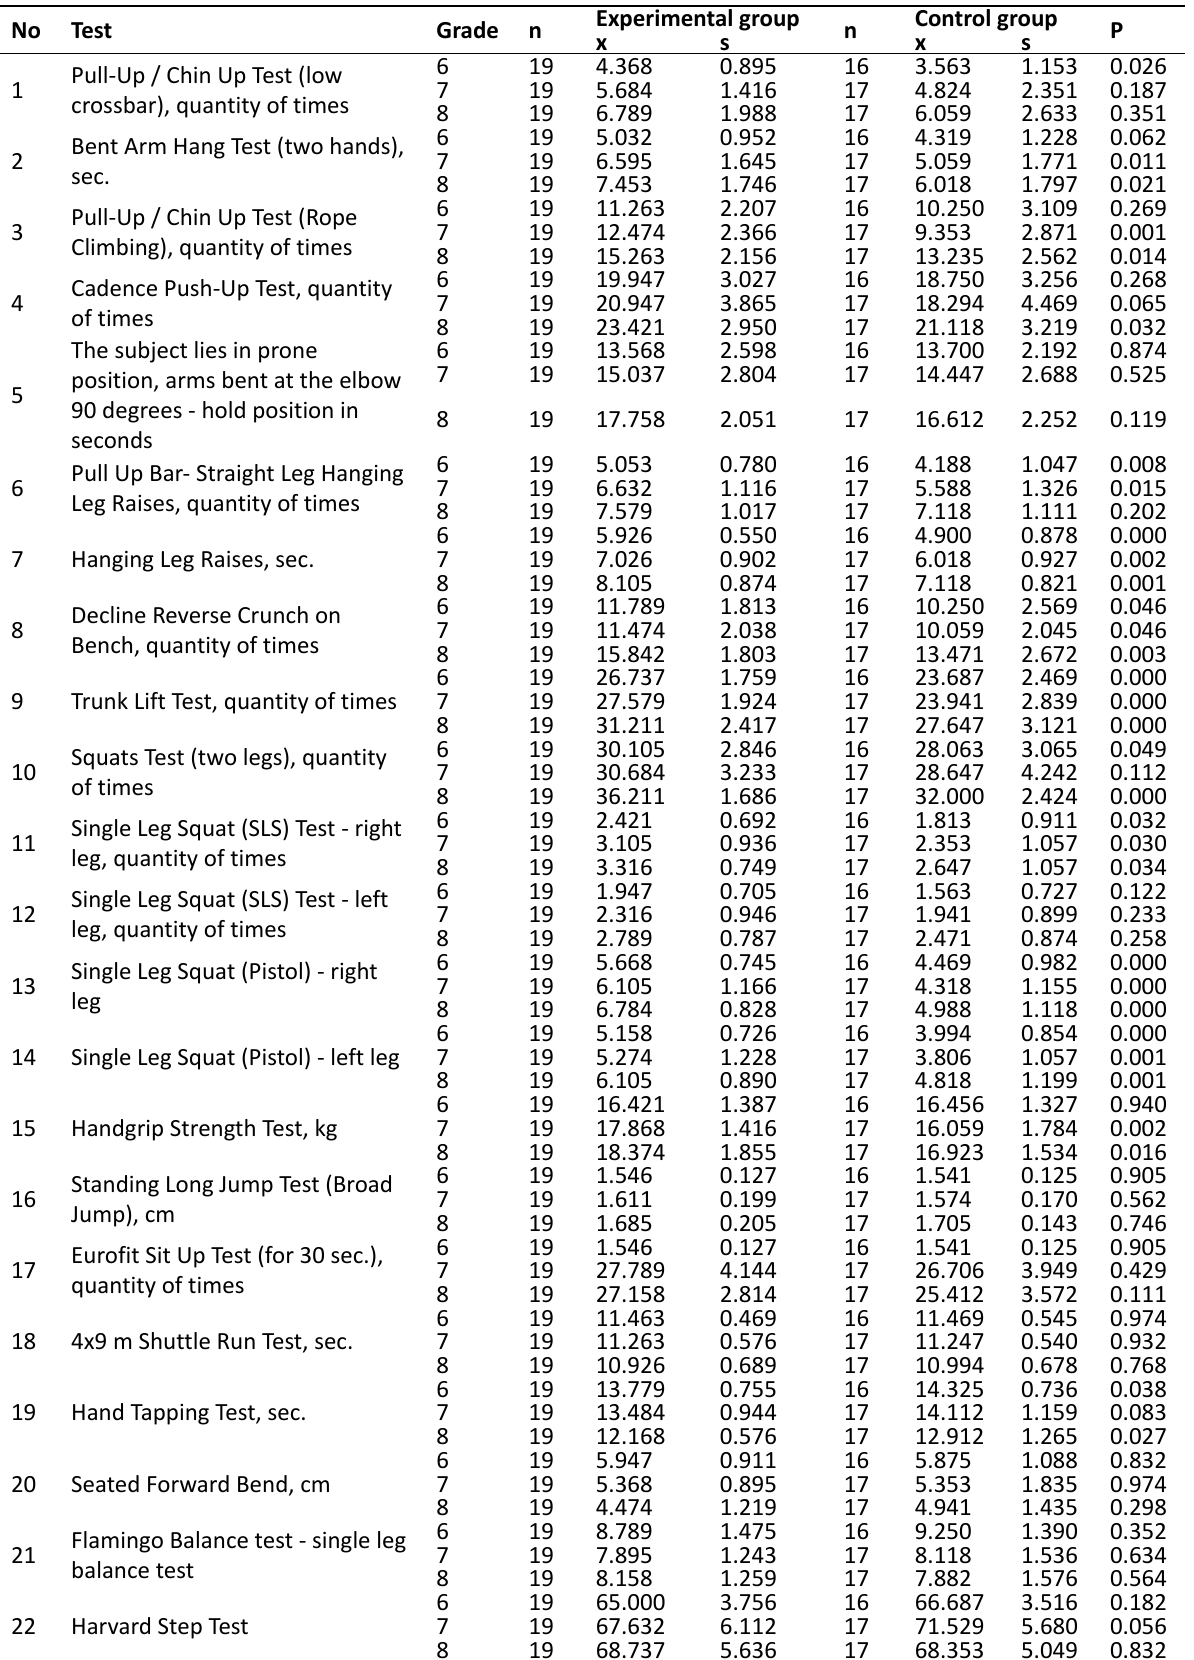
Table 6. Comparative analysis between the levels of strength fitness of the 6 th -8 th grade boys of the experimental